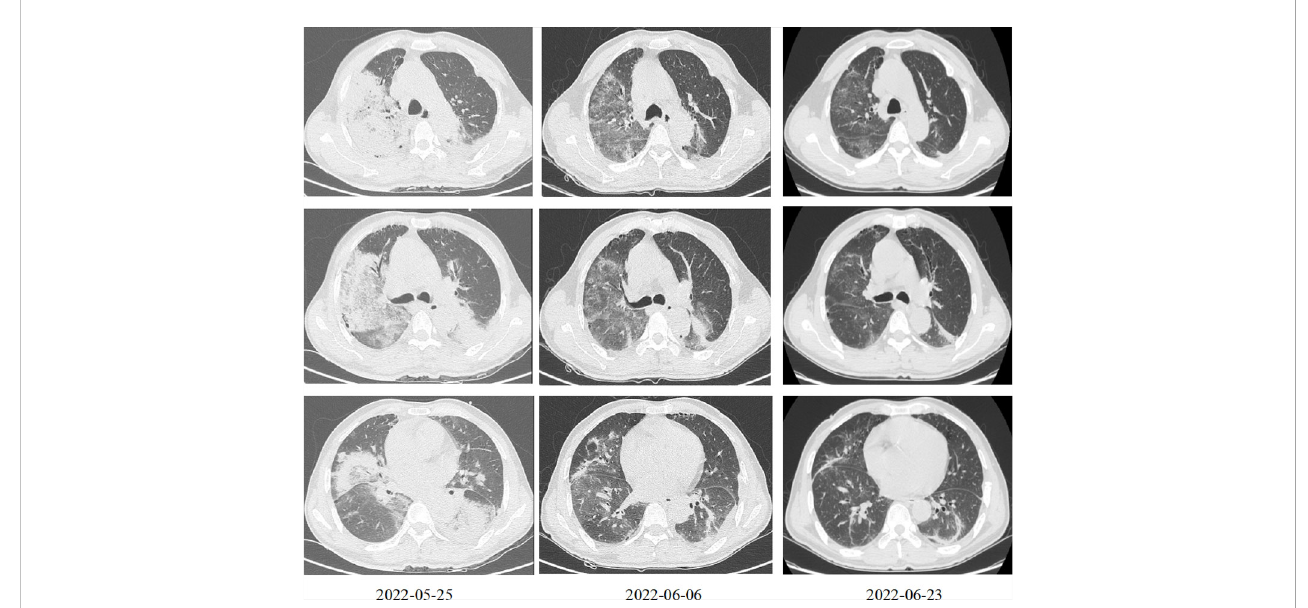
FIGURE 1 Chest computed tomography at different time points after treatment. March 25, 2022: Bilateral multiple exudative foci in the lungs, large consolidation opacities, and a small amount of bilateral pleural effusion. June 6, 2022: The exudative foci of both lungs were less absorbed than before. June 23, 2022: The exudative foci in both lungs were further absorbed as compared to